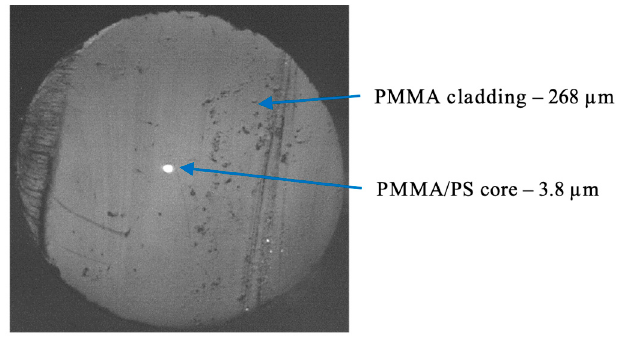
Figure 3. Cross section of the polymer optical fiber (POF) used for Bragg grating inscription. PMMA: polymethyl methacrylate; PS: polystyrene.